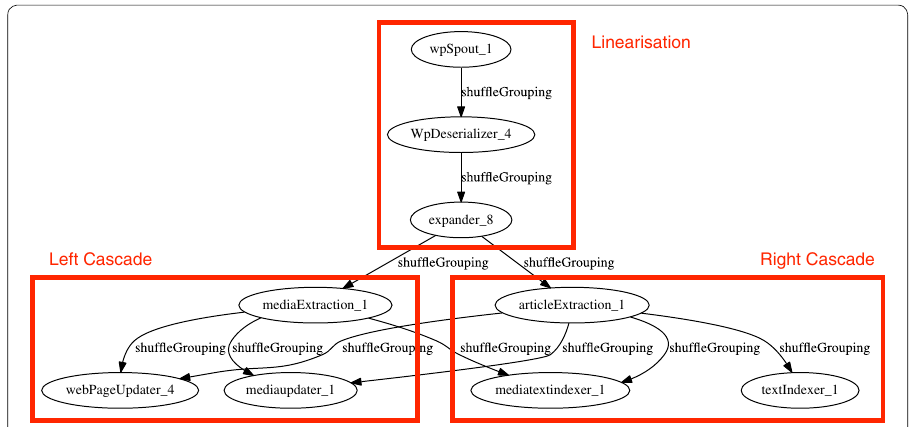
Fig. 8 SocialSensor App, OSTIA sample output partially linearised (top) and cascaded (bottom left and